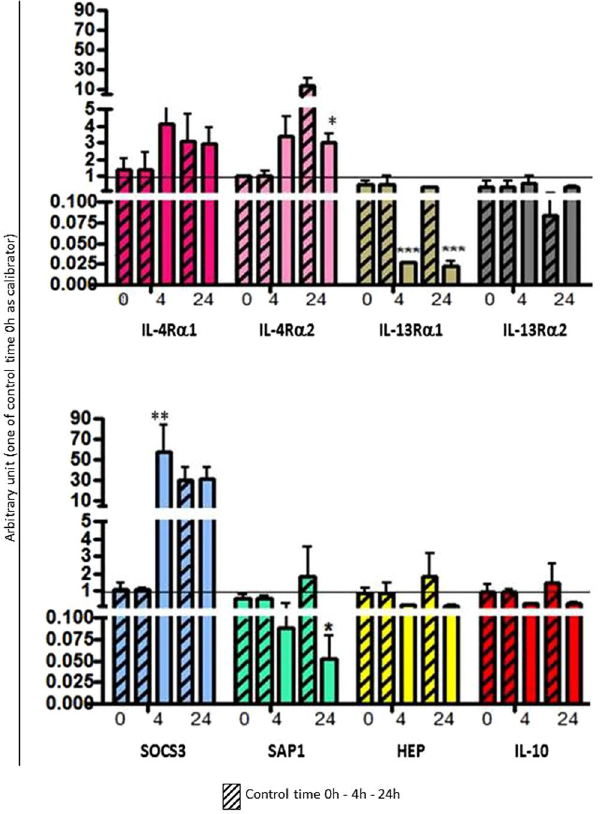
Figure 8. Biological activity of sea bass recombinant IL-4/13B. The expression level of genes coding for IL- 4R α 1, IL-4R α 2, IL-13R α 1, IL-13R α 2, SOCS3, SAP1, HEP and IL-10 was determined in HK leukocytes after stimulation with the sea bass recombinant IL-4/13B. Transcription values were expressed as a ratio relative to 18S rRNA in the same samples. The quantitative PCR amplification was performed in PCR arrays and each point represents the mean + SD of cells from 4 individual fish. * p < 0.05 with respect to the time 0 control; ** p < 0.01 with respect to the time 0 control; *** p < 0.001 with respect to the time 0